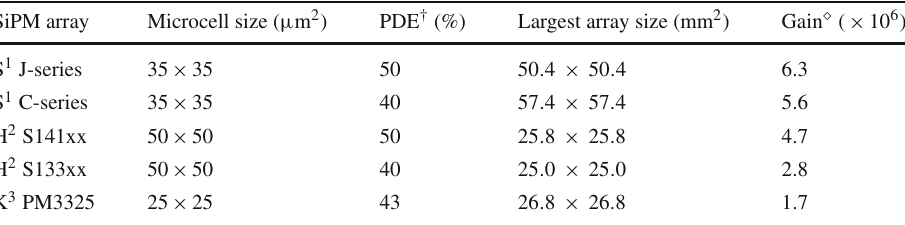
Table 3 SiPM arrays available